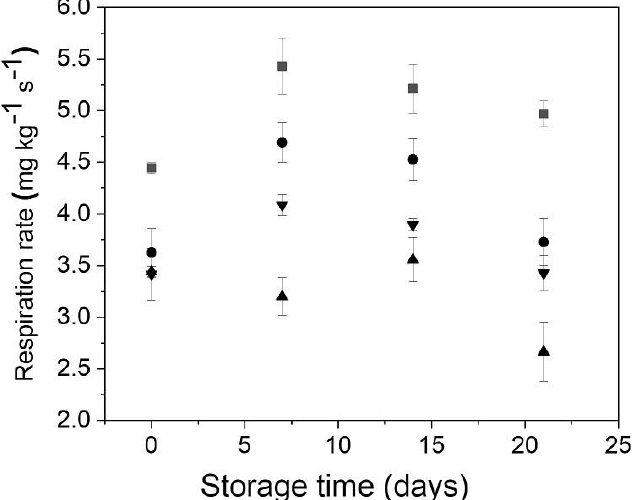
Figure 3. Behavior of the Andean blueberry respiration rate during storage. Control ( ■ ), alginate (●), alginate/CNFs 0.1% ( ▲ ), alginate/CNFs 0.3% ( ▼ ).